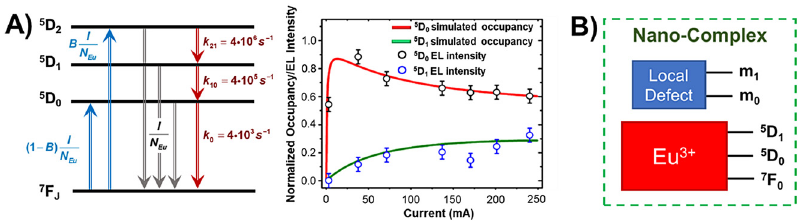
Figure12: (A)(Left)relevantenergylevelsandtransitionsofaEu 3 + ion.Bluearrowsindicatetheexcitationpathways,blackarrowsthecarrier- induced de-excitation, and red arrows the radiative and nonradiative transitions. (Right) simulations of the level occupancy as a function of injection current for a value of the branching parameter B = 0.5. (B) Extension of the Eu complex model, which includes the local defect in the excitation scheme. [Reprinted (adapted) with permission from a study by Mitchell et al. [22], Copyright 2019, American Chemical Society].